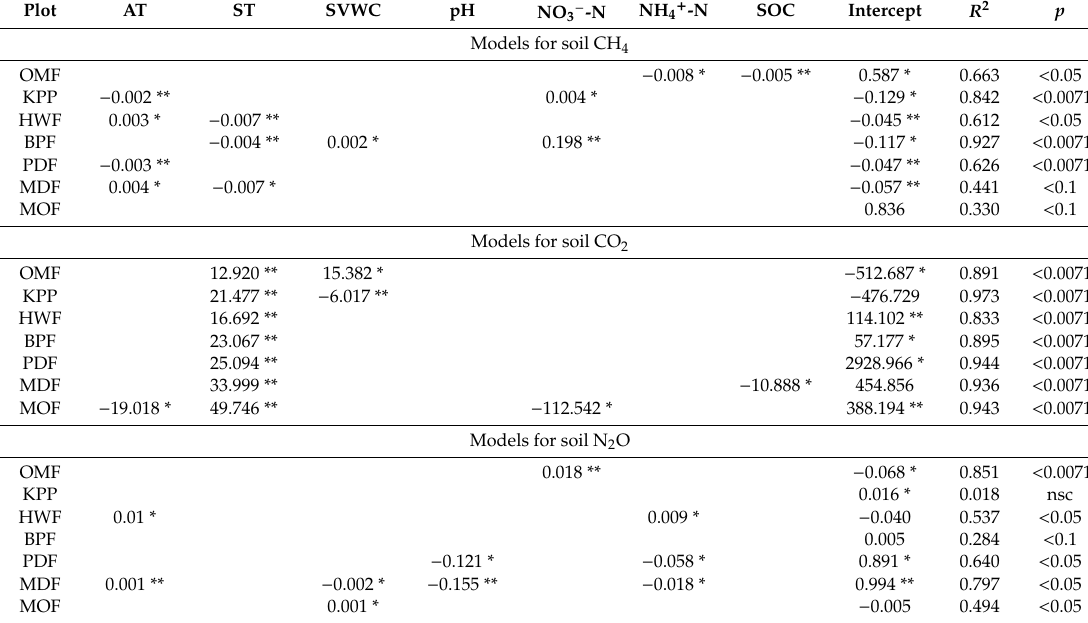
Table 3. The driving factors of CH 4 , CO 2 , and N 2 O fluxes in seven types of vegetation at the Maoershan Ecosystem Research Station in Northeast